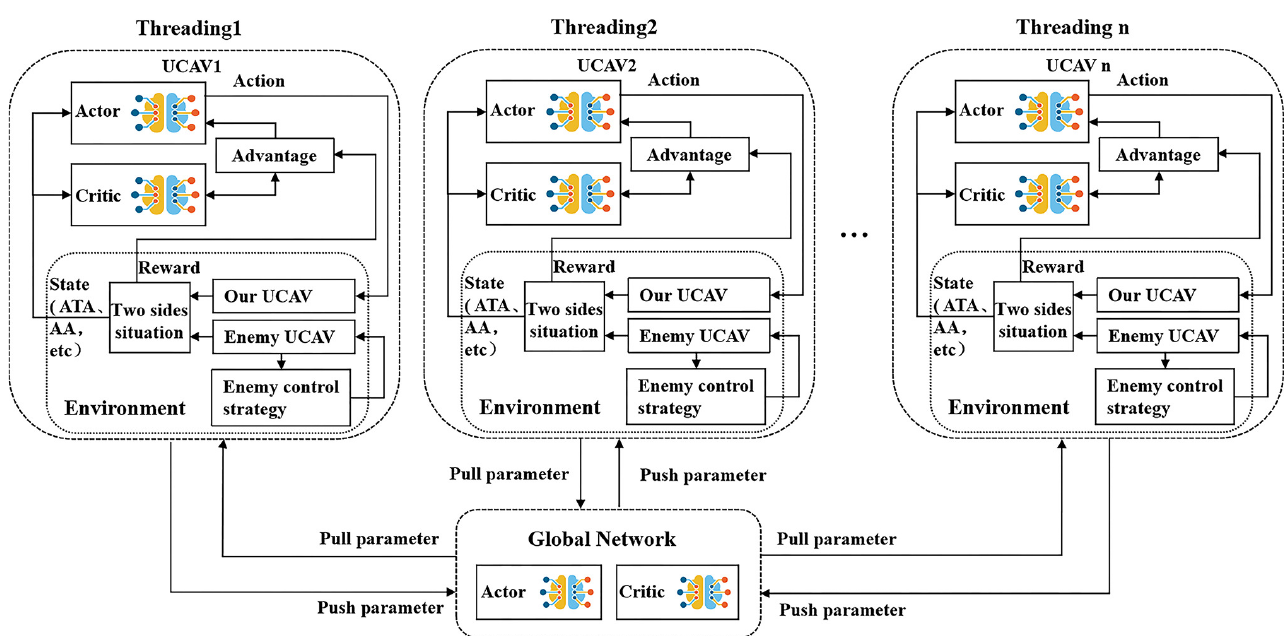
Figure 3. The A3C deep reinforcement learning asynchronous